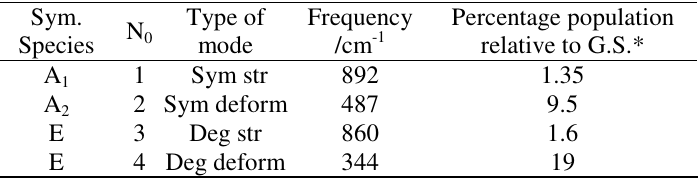
Table 3. Approximate populations of the fundamental vibrational states at 298 K. Sym.